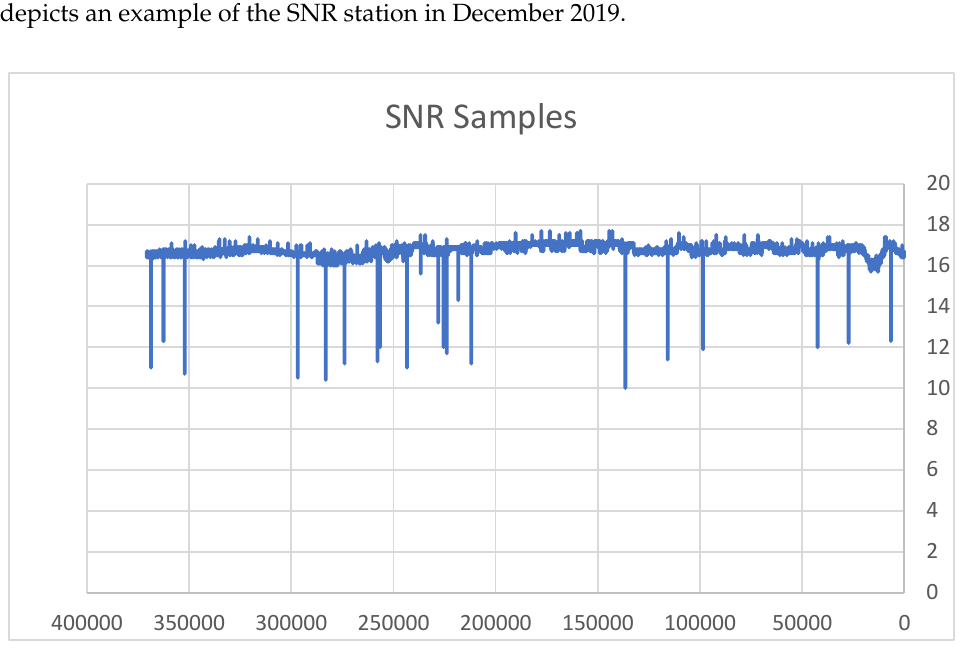
Figure 3. SNR measurement collection of the attenuation levels.